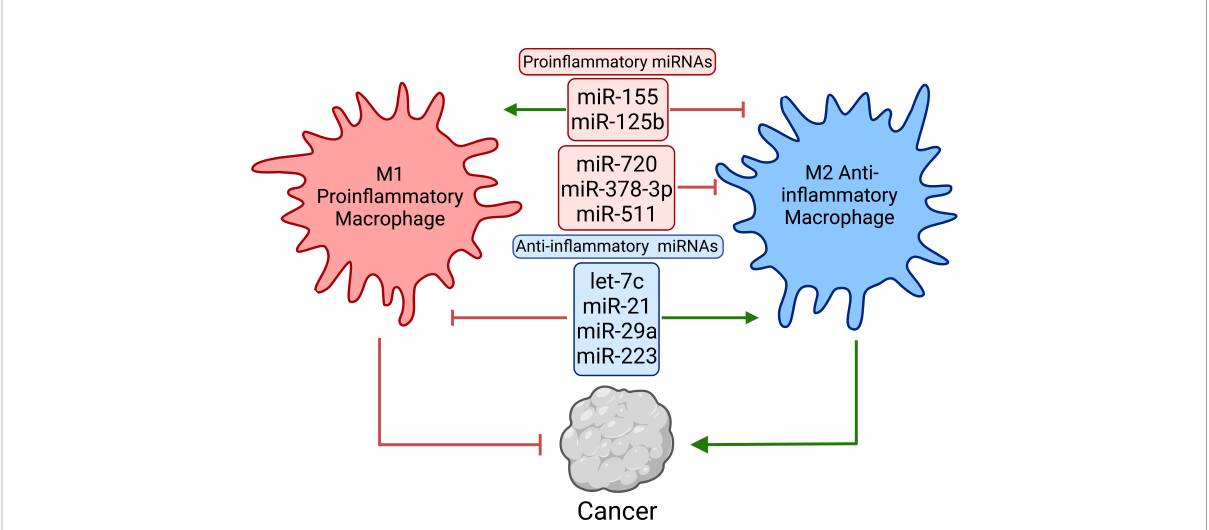
FIGURE 5 Macrophage miRNAs regulate pro- and anti-in fl ammatory macrophage skewing and function. Macrophages exist on a continuum on the M1 – M2 axis. M1 macrophages are considered proin fl ammatory and promote anti-tumor functions, whereas M2 macrophages are anti-in fl ammatory and immune suppressive. Macrophage miRNAs post-transcriptionally reinforce the identity of and regulate the effector function of M1/M2